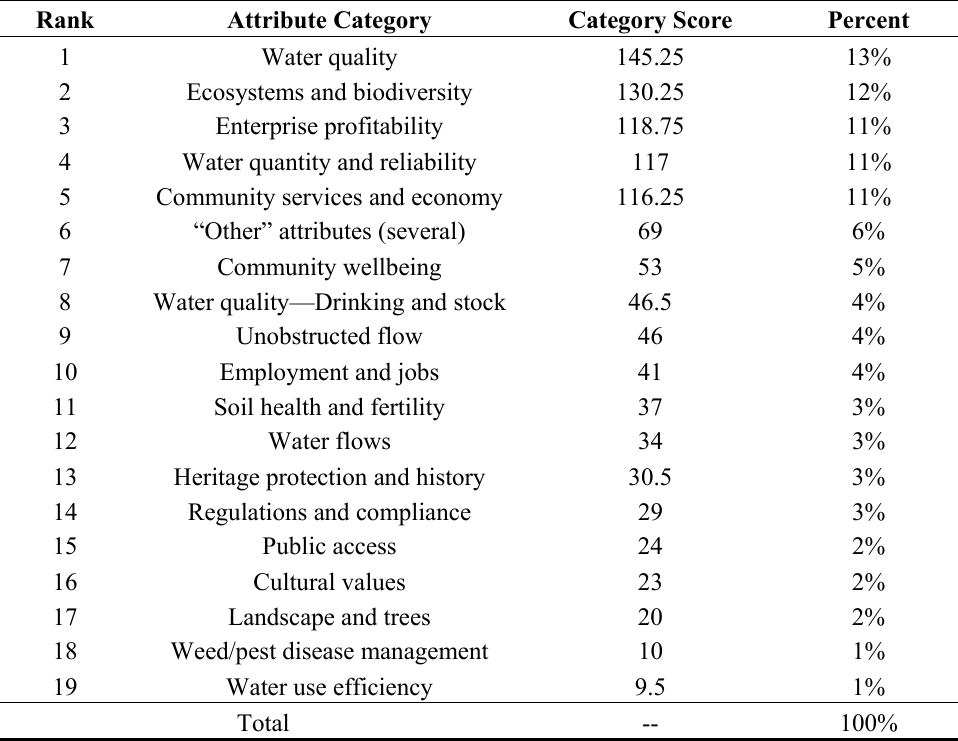
Table 2. Qualitative attribute scores from stakeholder consultation